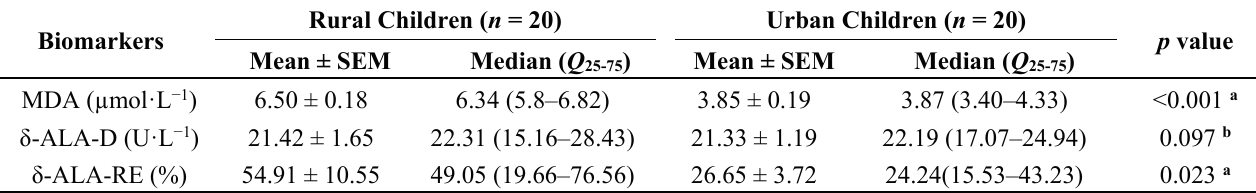
Table 5. Biomarkers of oxidative stress in rural and urban